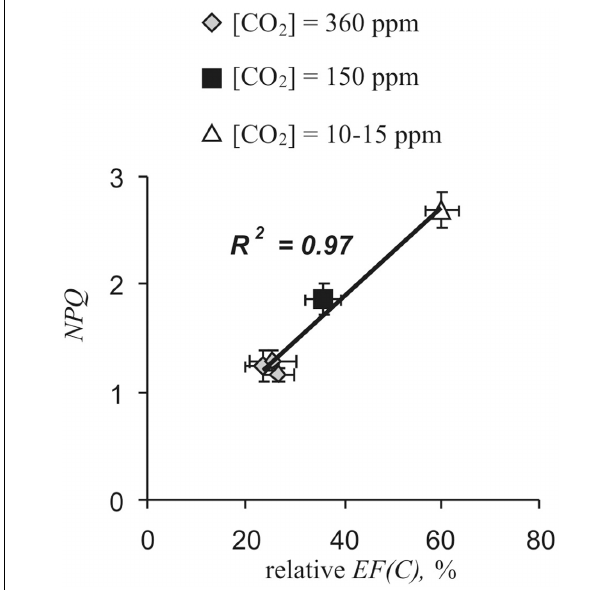
FIGURE 8 | Fluorescence non-photochemical quenching ( NPQ ) was plotted against relative cyclic electron flow [relative EF(C) ] under different CO 2 concentrations. Relative EF(C) and NPQ were taken from the Tables 1 , 4 (unheated plants).